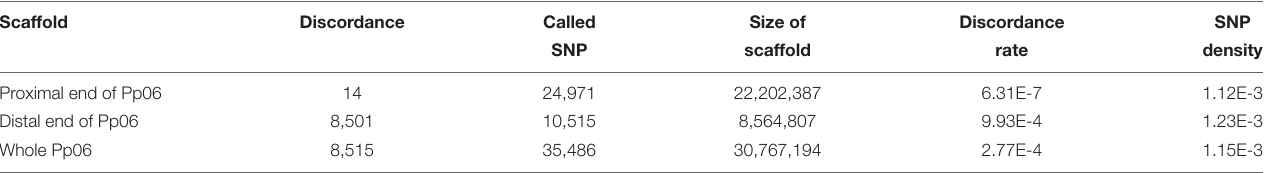
FIGURE 2 | A comprehensive analysis of the genetic differences between the wild-type and the bud sport mutant. (A) Whole genome pattern comparison between the wild-type and the bud sport mutant. Wild-type (flat fruit shape) is shown in red, bud sport mutant (round fruit shape) is shown in blue. Homozygous reference is numbered as 0 and homozygous variance is numbered as 2, heterozygote is numbered as 1; (B) Genotype pattern comparison between the wild-type and the bud sport for scaffold Pp06. Wild-type is shown in red and the bud sport mutant is shown in blue. The transition site is located at 22,195,188 bp; (C) Genotype pattern comparison between the wild-type and the bud sport at the distal end of the Pp06 chromosome. Wild-type is shown in red and the bud sport mutant is shown in blue; (D) Pattern of distribution of ratio of genotype depth between bud sport and wild-type at both local and whole genome level. The distribution pattern of the genotype depth ratio between the bud sport and the wild-type on the local level is shown in red and the distribution pattern of the genotype depth ratio between the bud sport and the wild-type on the whole genome level is shown in blue. The local segment is the distal end of scaffold Pp06 (from 22,195,188 bp to the telomere). The whole genome level includes all chromosomes; (E) The genotype depth ratio between the bud sport and the wild-type on the distal end of the Pp06 chromosome.